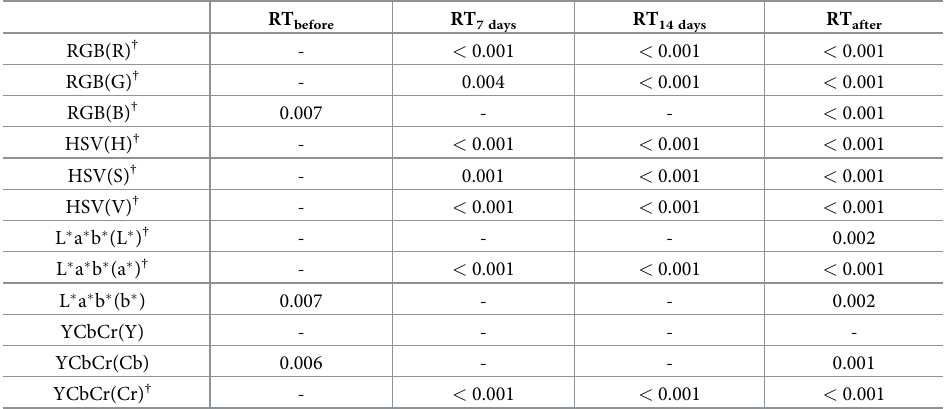
: approximately n days after the first fraction of Abbreviations–RT before : before starting radiotherapy, RT n days radiotherapy, RT after : approximately 10 days after radiotherapy completion. Bonferroni adjustment. which considered the adjusted significance level of 0.0167, was applied for multiple comparisons. † indicates statistical significances ( p < 0.05) of longitudinal changes in the values of color space parameters within each group across time and differences in those for the interaction of time and group via a two-way repeated measures analysis of variance (RM-ANOVA).